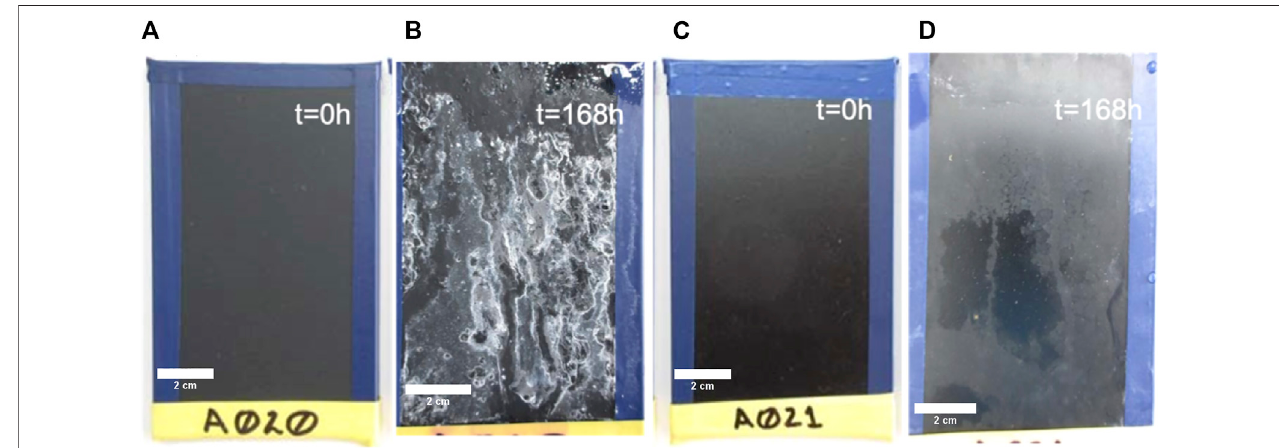
FIGURE11| Raman spectraoftheA020and A021coatings beforeand after the NSSt.